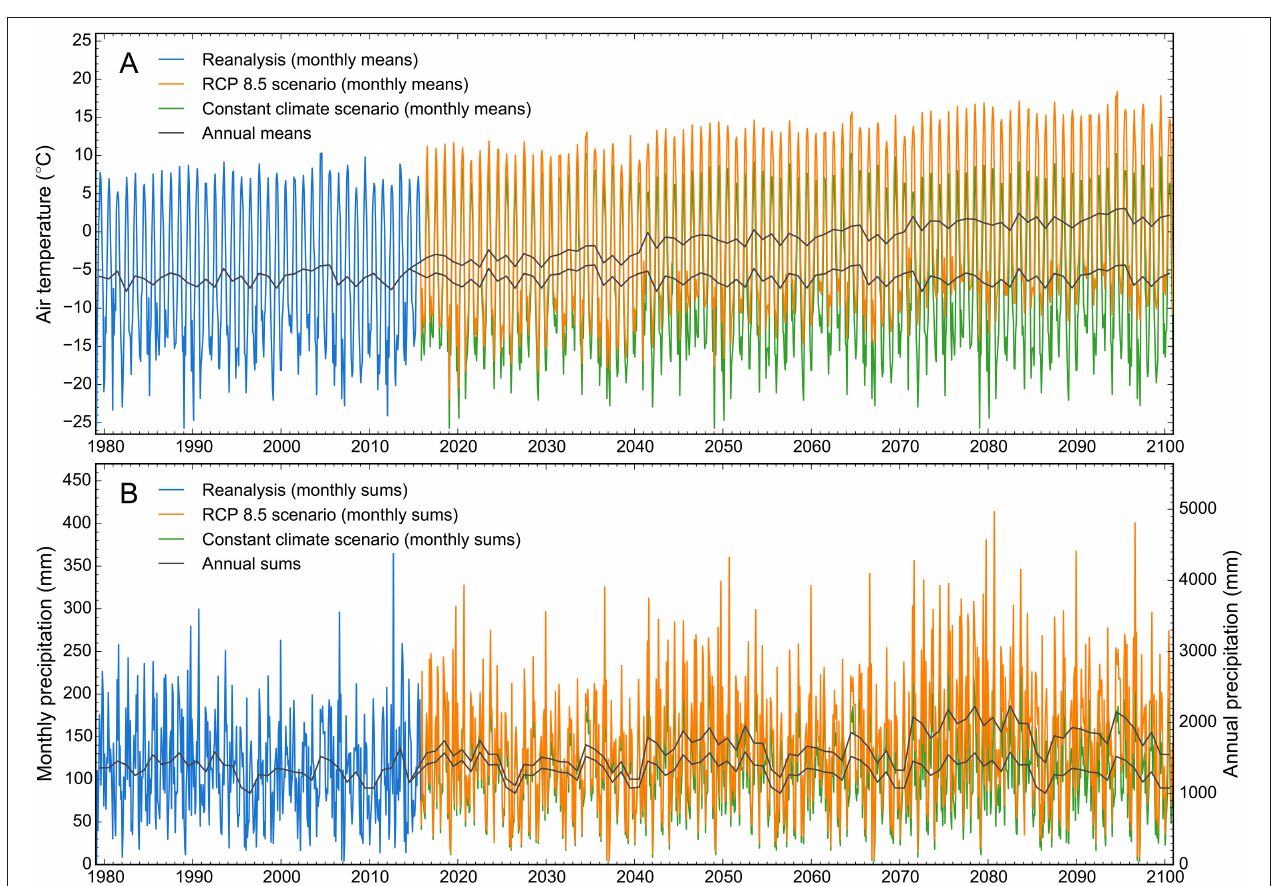
FIGURE 3 | (A) Near-surface air temperature and (B) precipitation time series taken from the WRF-downscaled ERA-Interim reanalysis (January 3, 1979 to October 29, 2015, used for hindcast) and the two forecast scenarios RCP 8.5 and constant climate (October 30, 2015 to December 31, 2100). The data are taken from the WRF gridpoint with center at 63.42 ◦ N and 146.18 ◦ W and an elevation of 1,525 m